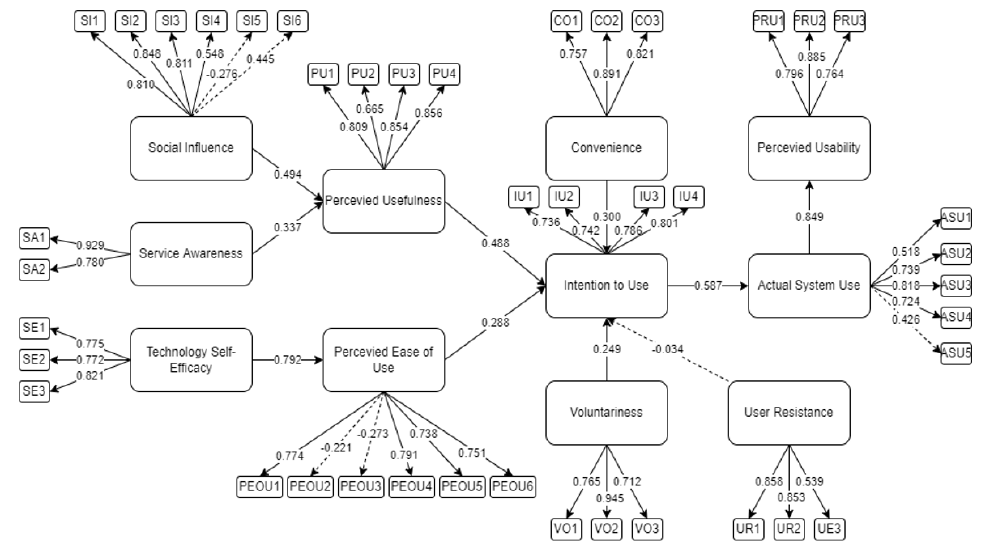
Figure 3. The final SEM to determine factors affecting the perceived usability of a mobile mental health application.